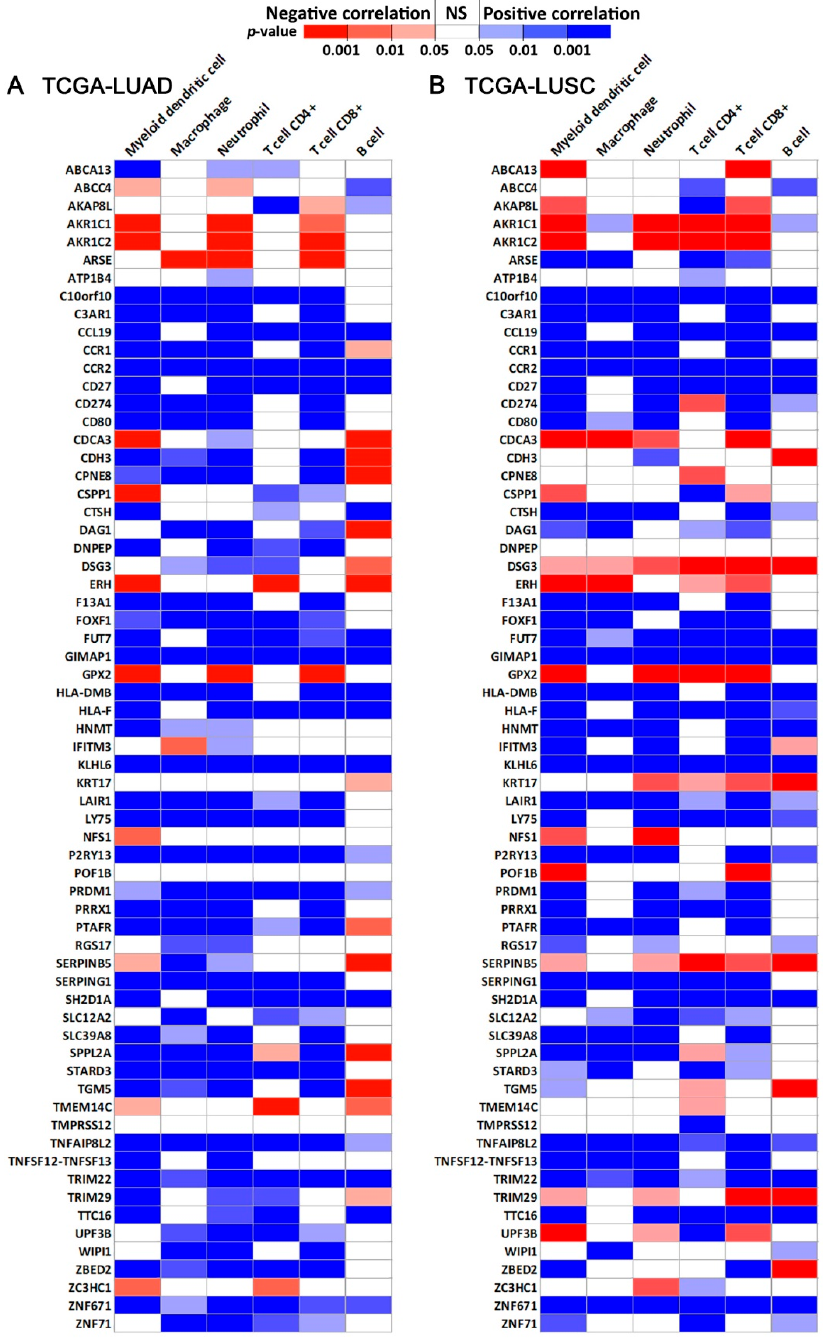
Figure 2. Association between immune infiltration and expression of the multi-omics network genes (Figure 2C). ( A ) The correlation of gene expression with immune infiltration level in TCGA-LUAD patients ( n = 515) assessed with TIMER 2.0. ( B ) The correlation of gene expression with immune infiltration level in TCGA-LUSC patients ( n = 501) assessed with TIMER 2.0. NS: not statistically significant.